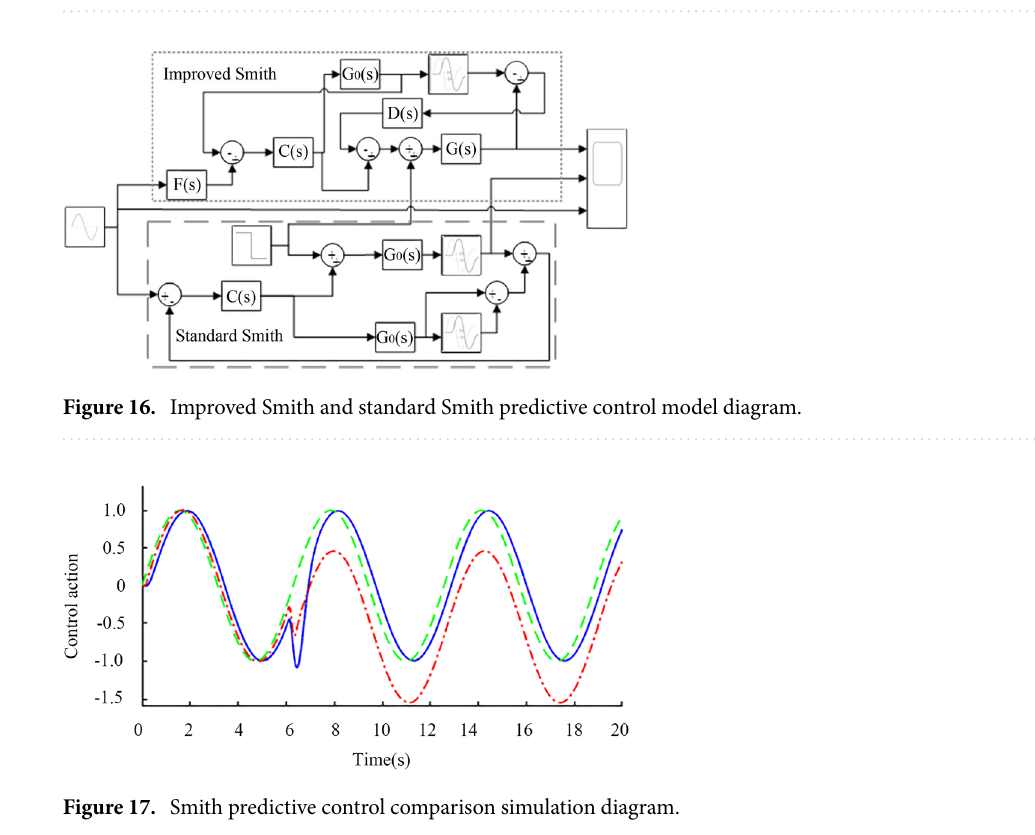
Figure 15. Perturbation response when a sinusoidal signal is input.